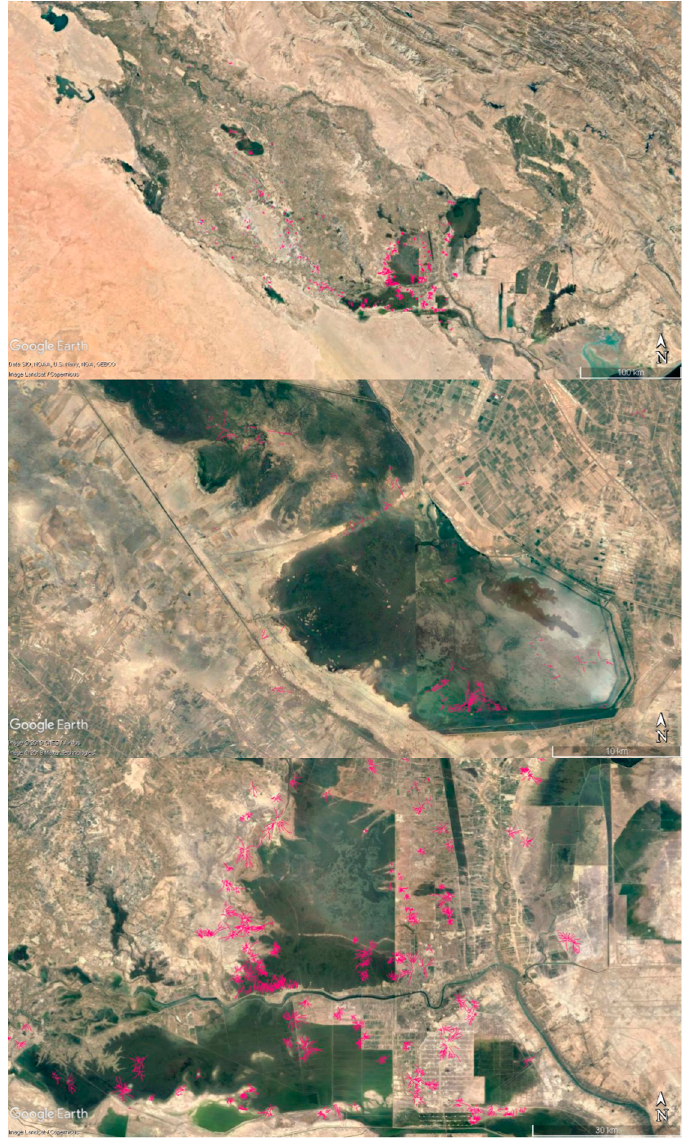
Figure 13. Hollow ways were frequently found in or at the edges of areas of shallow water of current marshland in the deltaic and marsh zones of Mesopotamia.